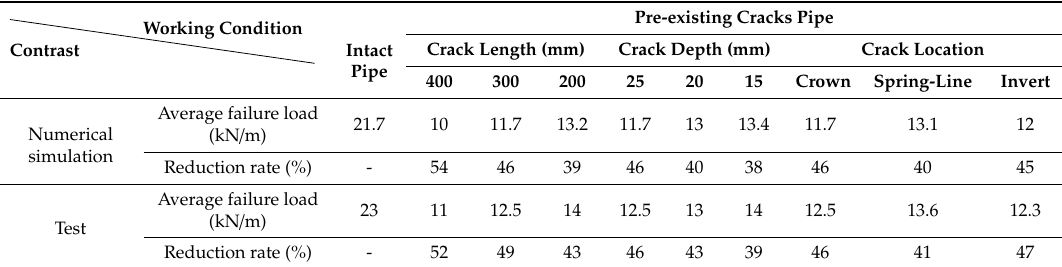
Table 6. Failure loads of the concrete